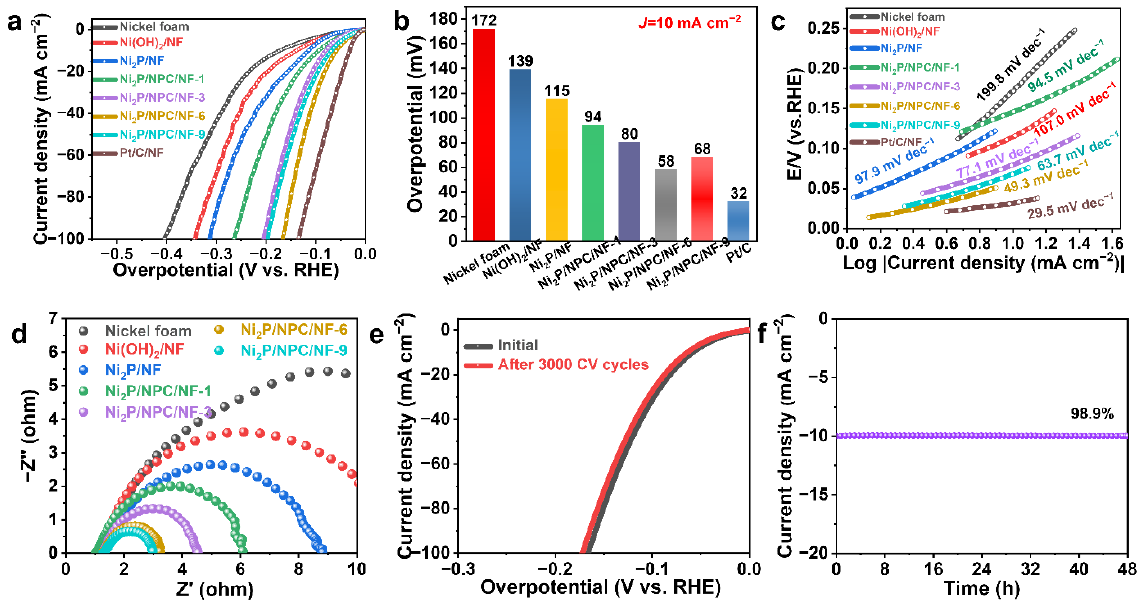
Figure 5. Diagrams of HER’s catalytic performance: ( a ) polarization curves, ( b ) corresponding overpotentials at 10 mA cm − 2 , ( c ) Tafel curves, ( d ) Nyquist plots of NF, Ni(OH) 2 /NF, Ni 2 P/NF, Ni 2 P/NPC/NF, Ni 2 P/NPC/NF-1, Ni 2 P/NPC/NF-3, Ni 2 P/NPC/NF-6, Ni 2 P/NPC/NF-9 and Pt/C of HER in 1 M KOH solution. ( e ) LSV curves of Ni 2 P/NPC/NF before and after 3000 cycles in 1 M KOH solution. ( f ) Timing current density curve for Ni 2 P/NPC/NF under a constant potential (overpotential = 58 mV vs. RHE) for 48 h.